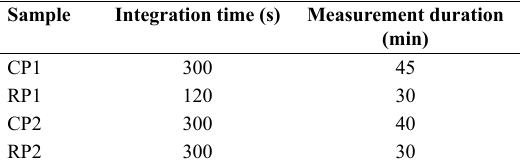
Table 1. Integration time used for in-situ XRPD